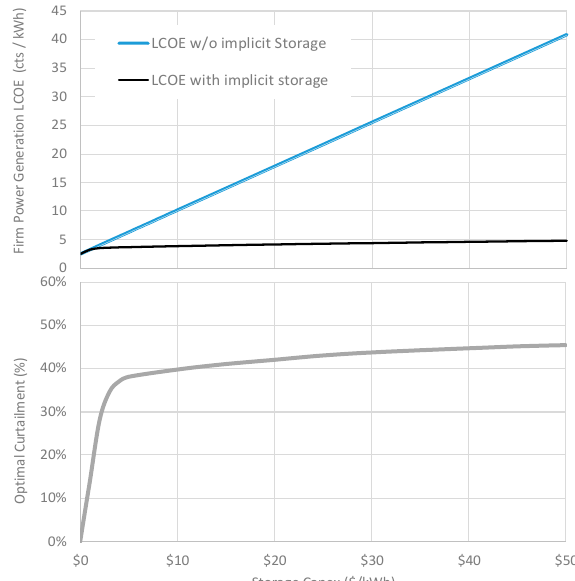
Figure 6. Comparing LCOE with and without implicit storage ( top ), and the optimum level of proactive curtailment ( bottom ) as a function of future storage costs. Note: this illustrative example if for the future NYISO-wide scenario @ 5%